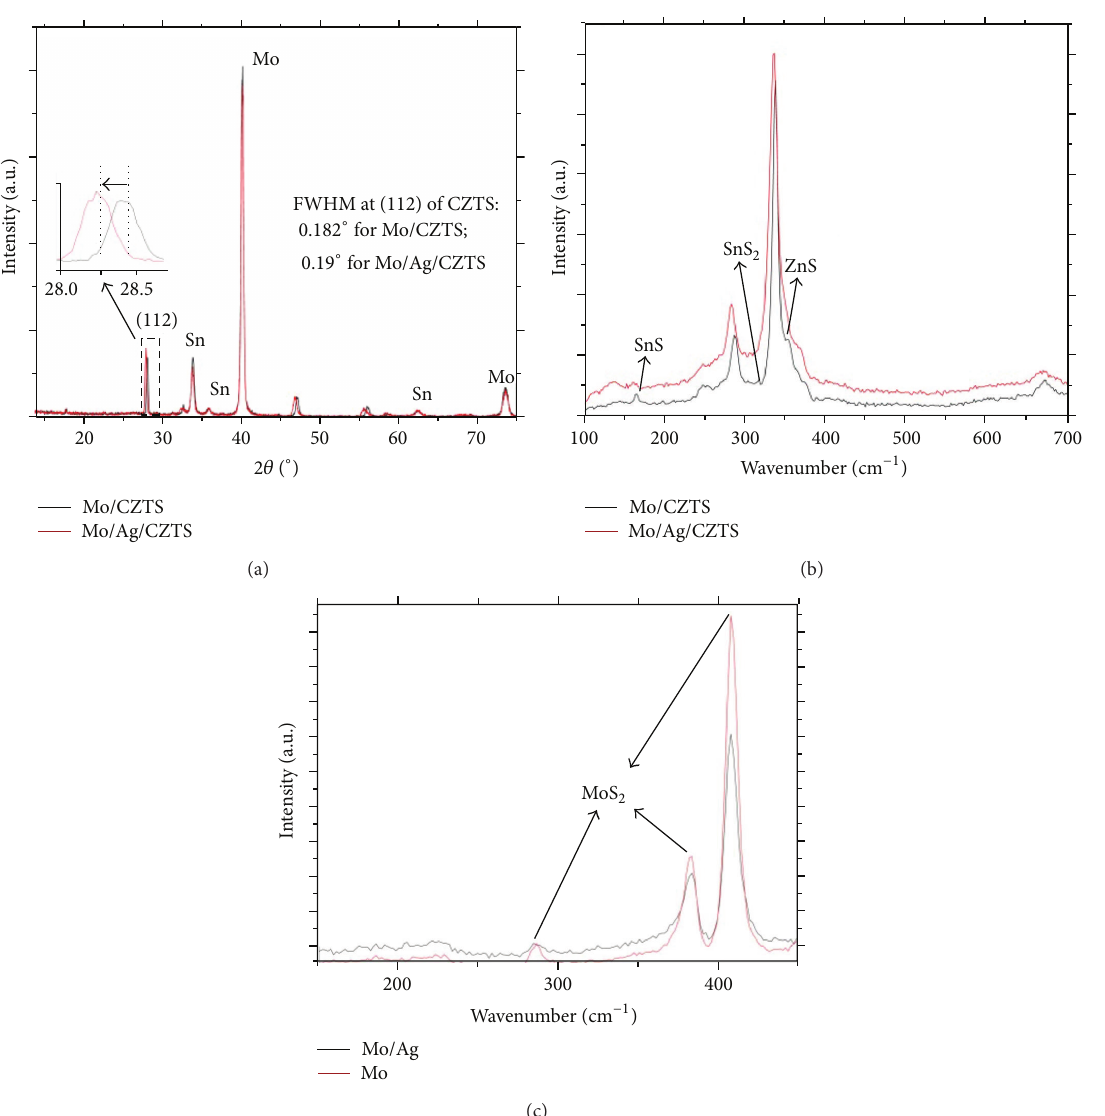
Figure 1: (a) X-ray diffraction (XRD) spectra of the CZTS thin films on Mo back contacts with and without the Ag intermediate layer; (b) Raman spectra of CZTS absorbers with and without 20 nm Ag intermediate layer; and (c) Raman spectra of samples in (a) with the absorber mechanically removed by the same method applied in